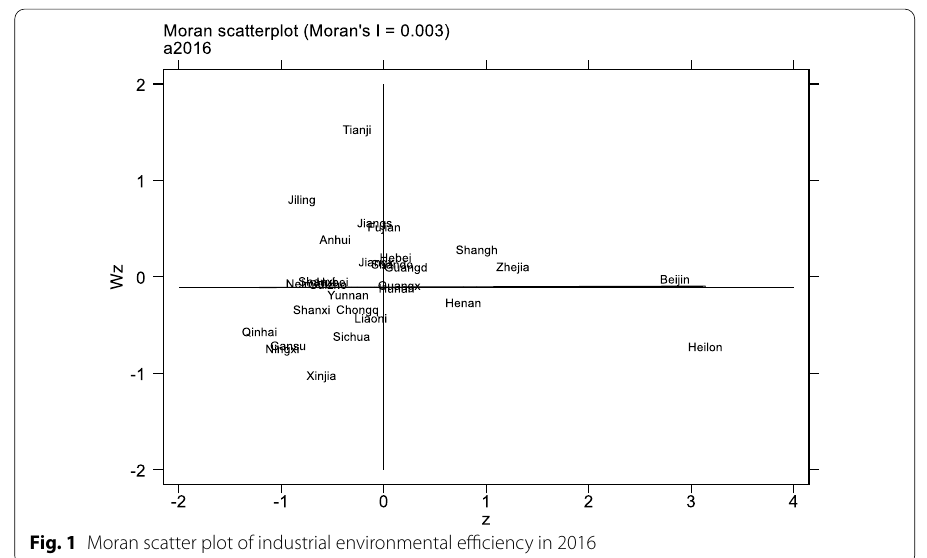
Fig. 1 Moran scatter plot of industrial environmental efficiency in 2016